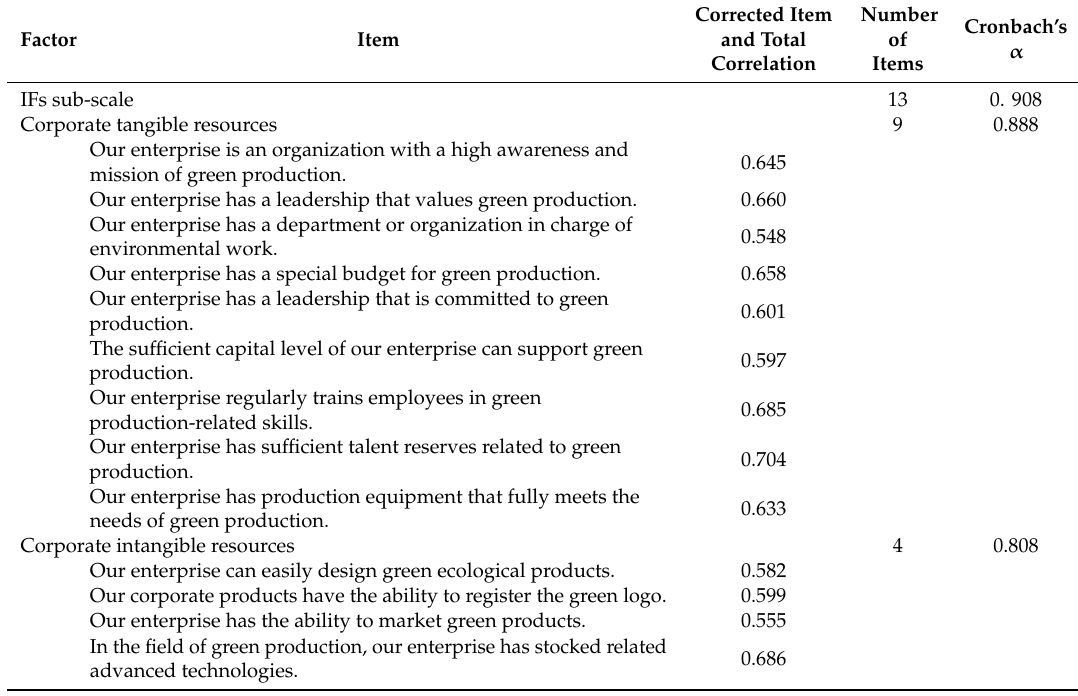
Table 5. Test results of the internal factors (IFs) sub-scale ( N =